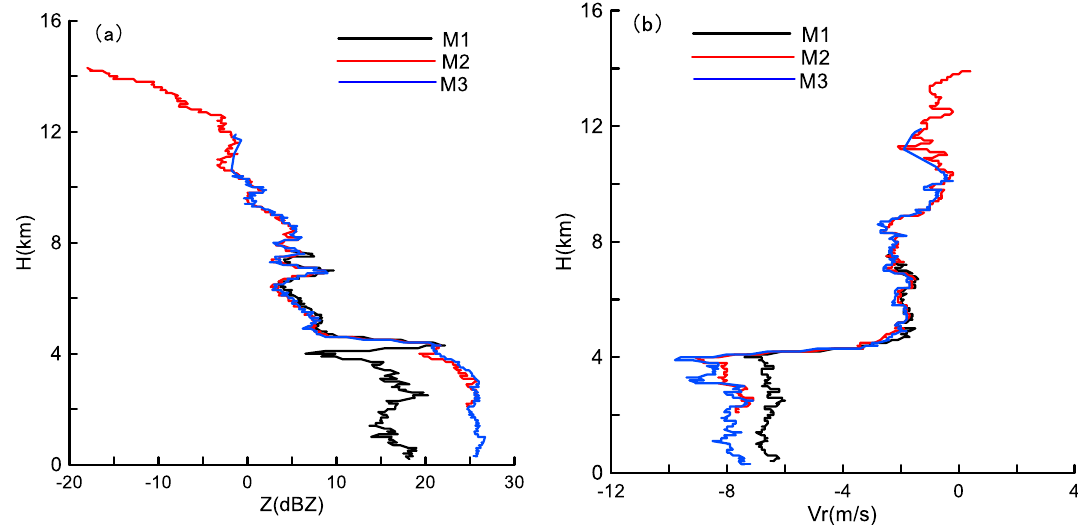
Figure 2. ( a ) Reflectivity and ( b ) dealiased velocity profiles obtained from the three modes for the 30th profile.